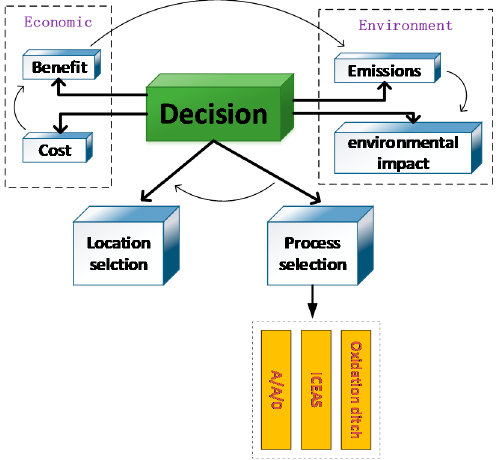
Figure 2. Economic ‐ environment trade ‐ off problem. Figure 2. Economic-environment trade-off